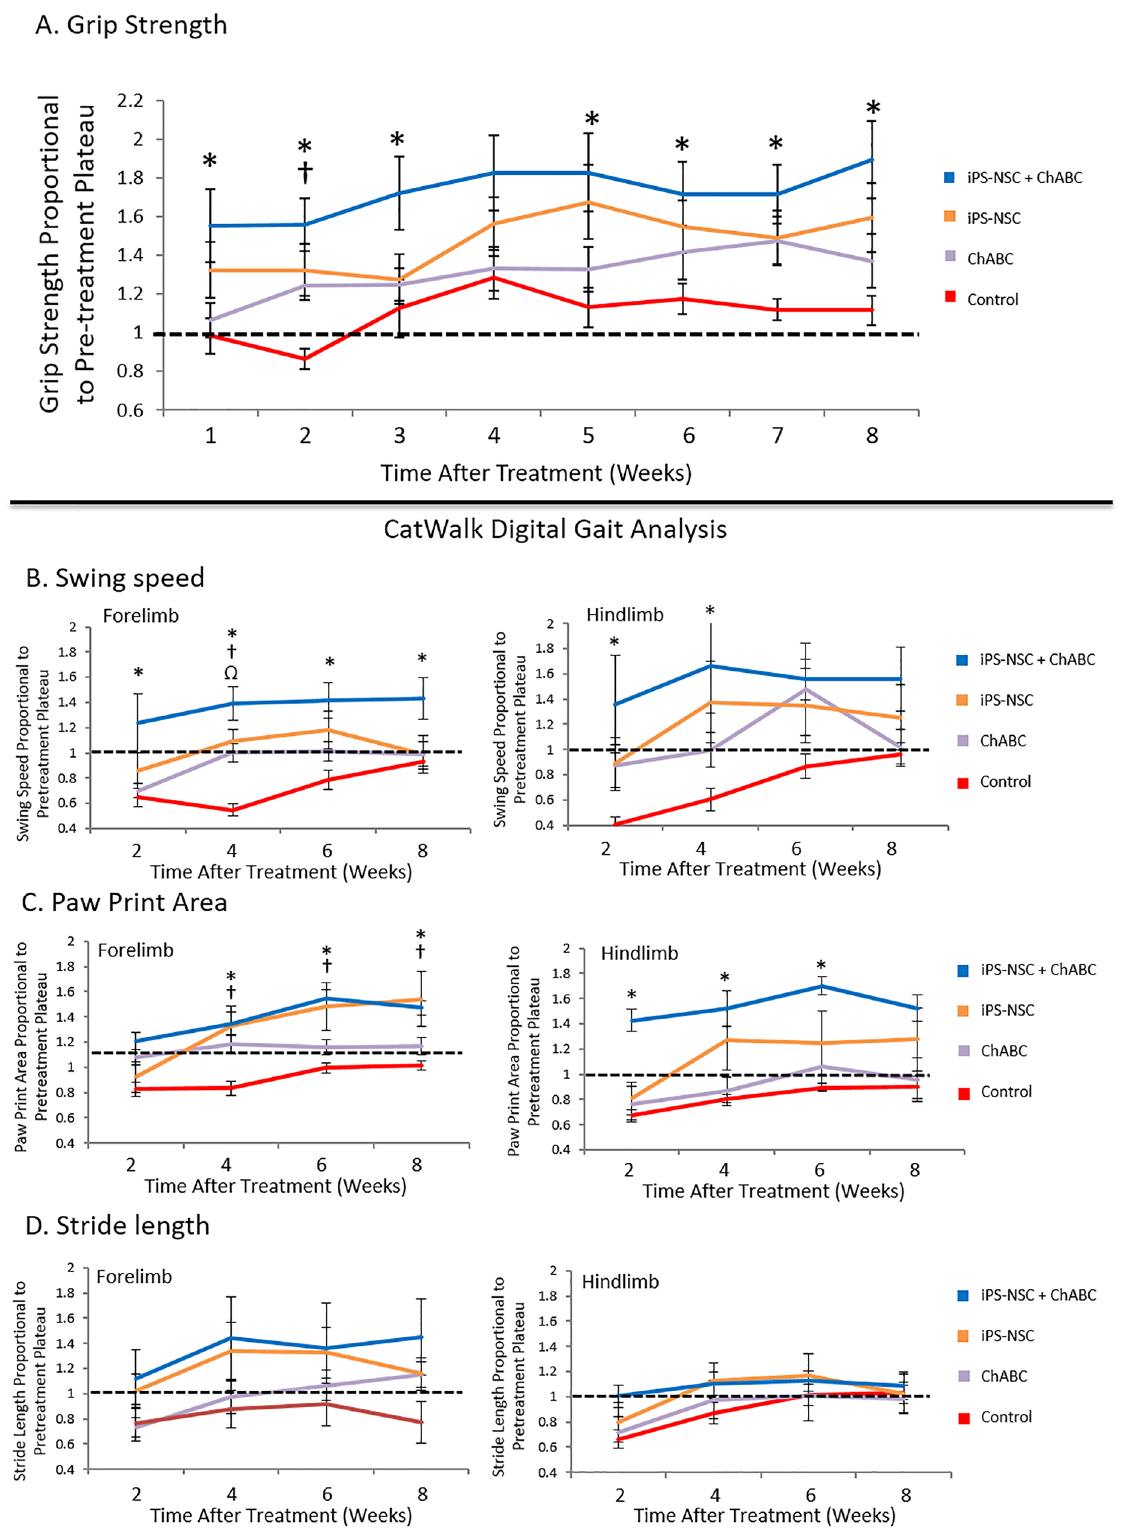
Fig 8. (A) iPS-NSC transplant combinedwith ChABC pretreatment improves recovery of forelimb grip strength in chronic SCI. Data are normalized to pretreatment (post-injury)baselinefunction with 1 representingno difference after treatment and values